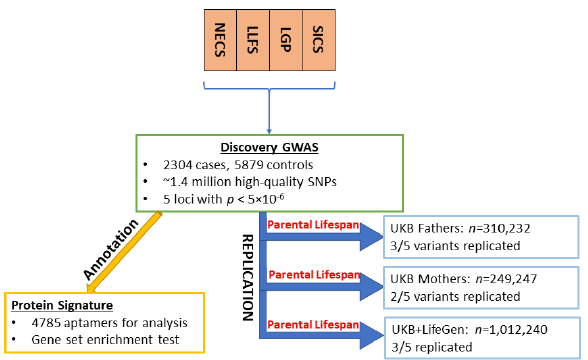
Figure 1. Flow chart of the study design.